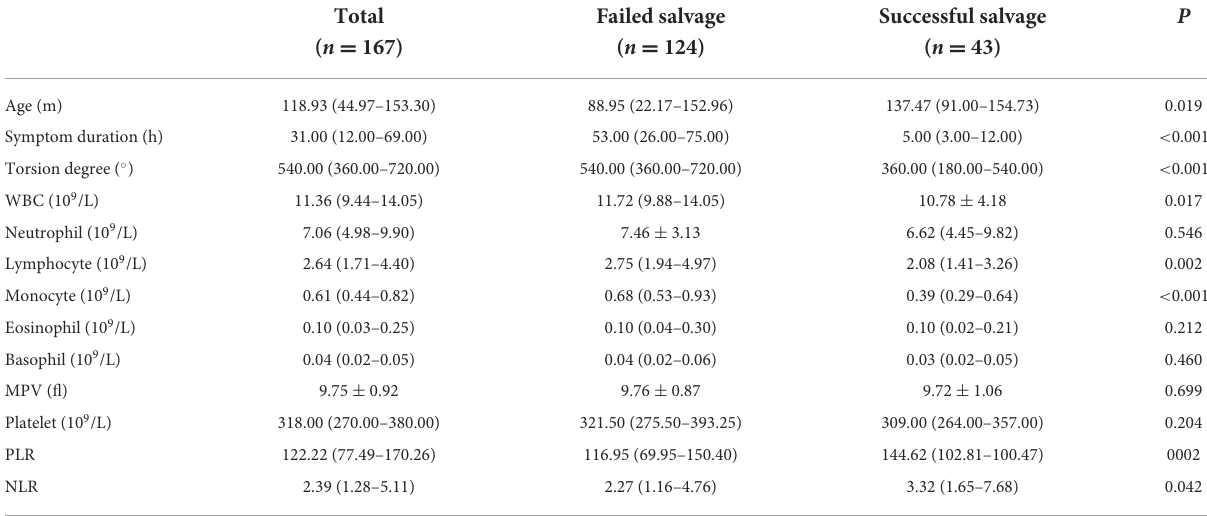
TABLE 2 Baseline characteristics of testicular torsion